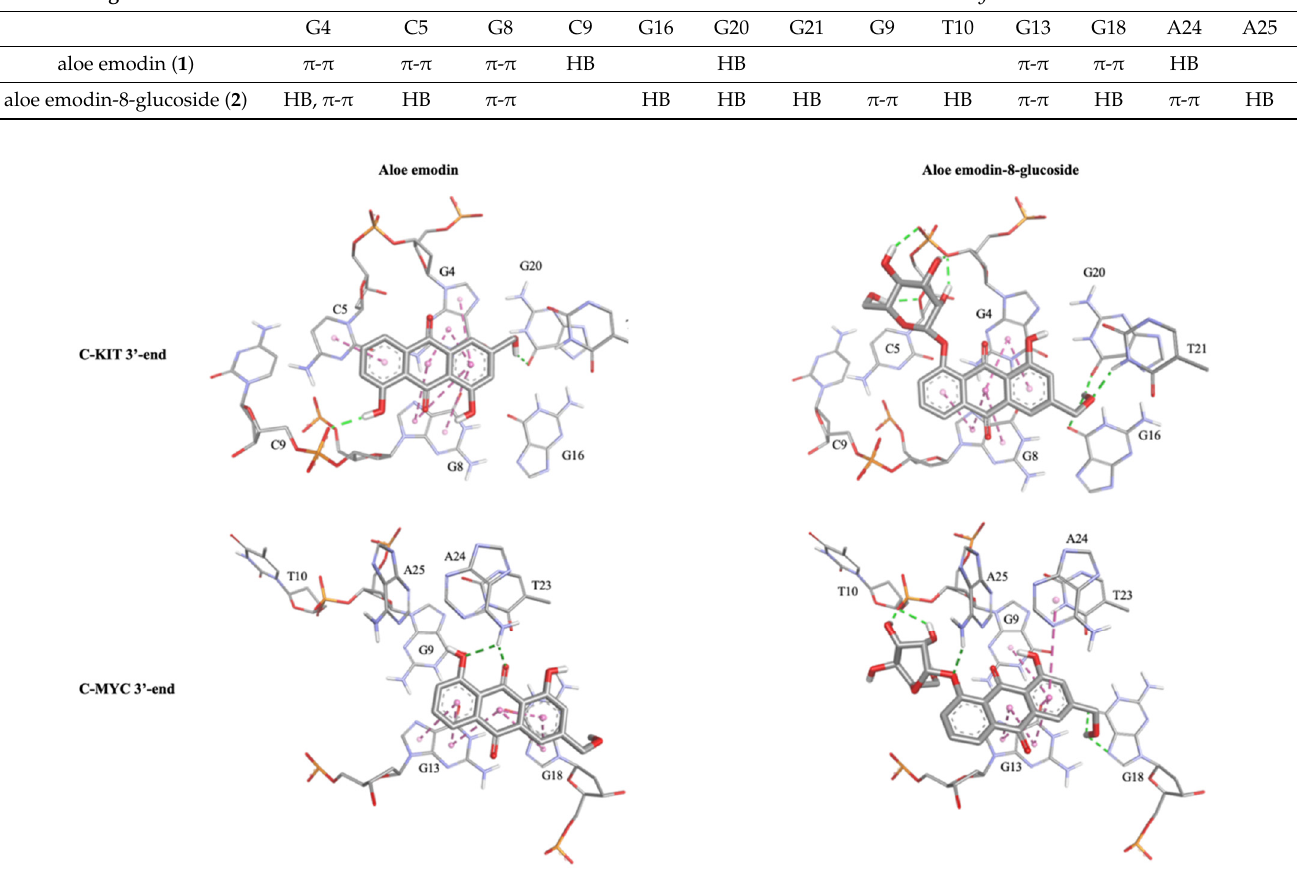
Figure 10. Detailed representations of the C-Kit and c-Myc binding sites, composed of the ligands (rendered in sticks) and key nucleotides (rendered in thick sticks and labeled). Non-bonded inter- actions were represented as dotted lines. Molecular graphics and analyses were performed using BIOVIA Dassault Systémes Discovery Studio Visualizer (DSV2021).